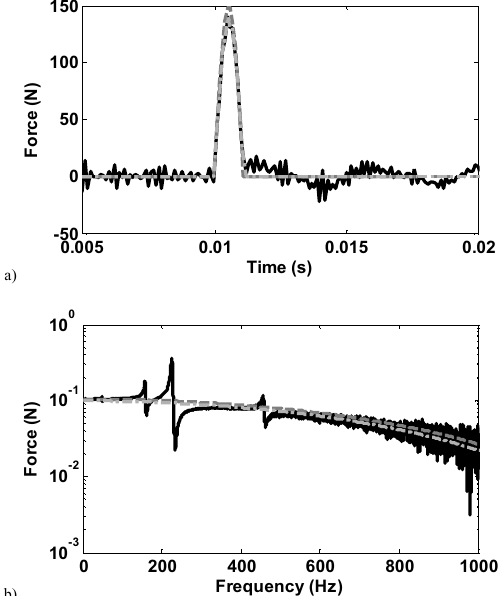
Fig. 9. Comparison of the original estimated force (——), the actual force (– – –), and the curve-fit force (– · – · ) in the a) time domain and b) frequency domain.